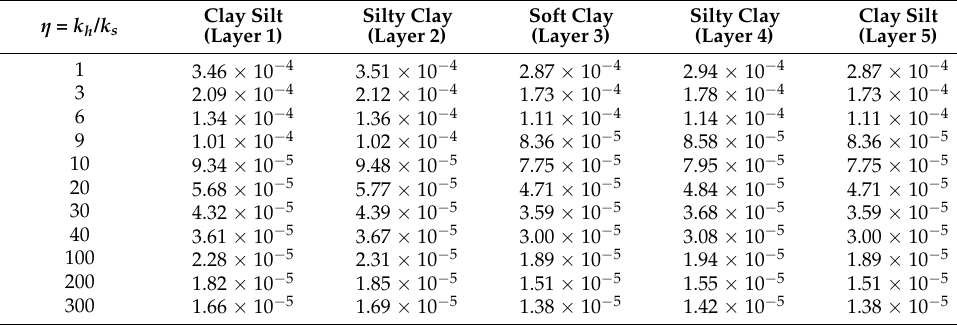
Table 4. An equivalent vertical permeability in